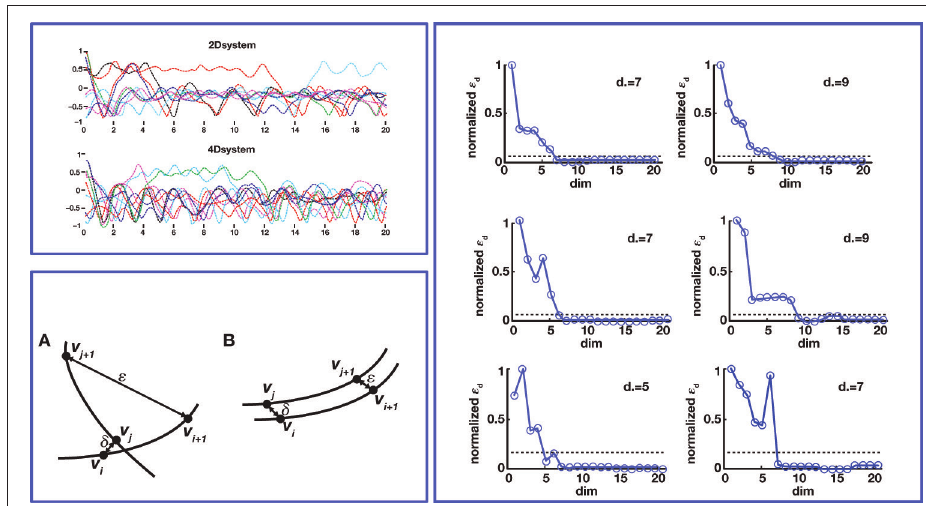
a one-dimensional output signal by combining values of the signal at different delays. So, an n -dimensional state vector s ( t ) is obtained from the output signal y ( t ) as st y t y t y t n ) ... ( ( − − − [ ∆ 1 . The method consists in building surrogate state vectors of increasing dimension until one can assess that the trajectories do not have self-intersections, using the Kaplan’s method. Right: Results of the δ – ε analysis for three preparations. The dynamical dimension of the combined system is assessed as the dimension that makes ε vanish when δ approaches zero. This was empirically assessed by setting a small threshold for epsilon. The plots on the left are with the 2D external system, those on the right are with the 4D system. This is consistently reflected by the difference in the corresponding estimated dimensions (from Karniel et al., 2005; Kositsky et al.,